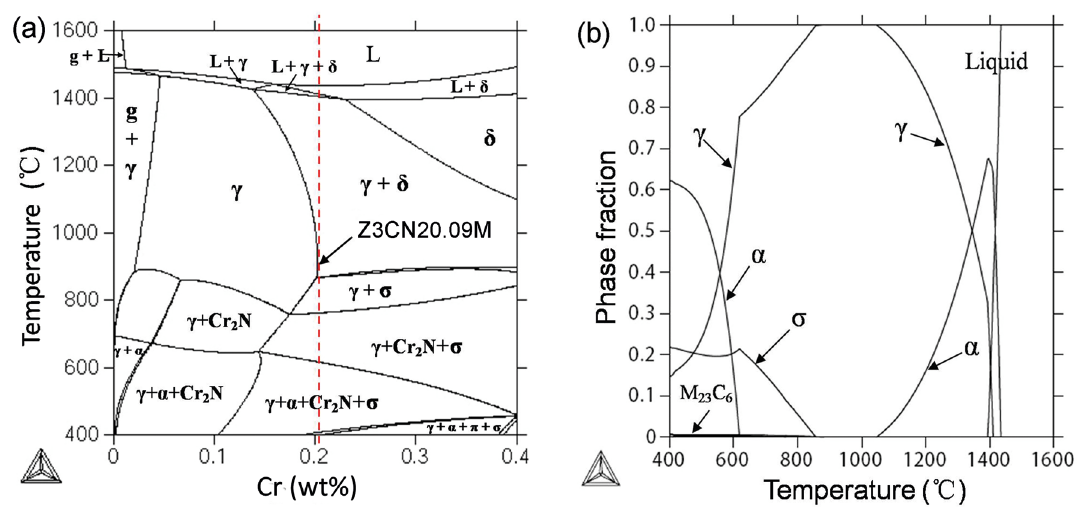
Figure 4. Phase diagram of Z3CN20.09M computed using Thermo-Calc software (a) the composition of Z3CN20.09M is indicated by a dashed line, (b) phase fractions of ferrite, austenite, σ-phase and M